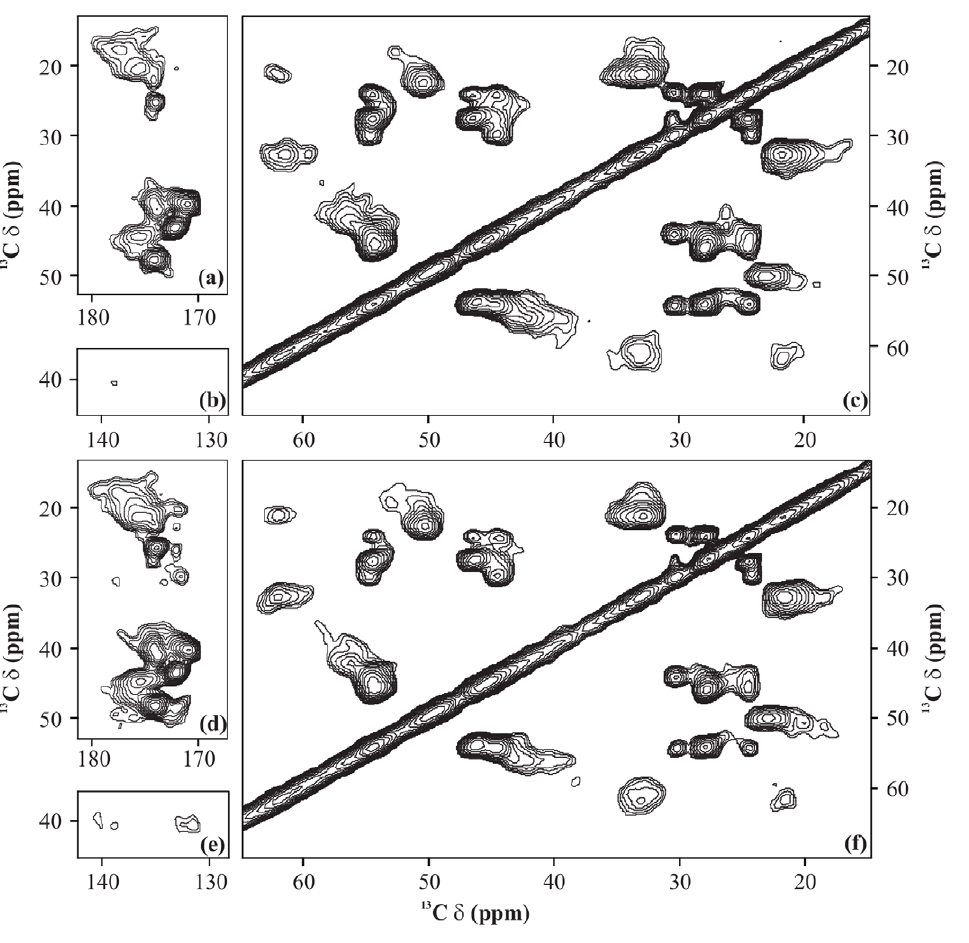
Figure 8. 13 C- 13 C spectra. 2D 13 C- 13 C spectra of A b 42 recorded at B 0 =16.43 T and n r =30 kHz. PARIS-xy (m=1)(N=1/2) recoupling scheme was employed during a 90 ms long mixing-time period using RF amplitudes of (a, b, c) 16 and (d, e, f) 30 kHz. Selected regions of 2D spectrum, covering (a, d) aliphatic-carbonyl, (b, e) aliphatic-aromatic, and (c, f) aliphatic-aliphatic cross-peaks, are shown in both the cases.